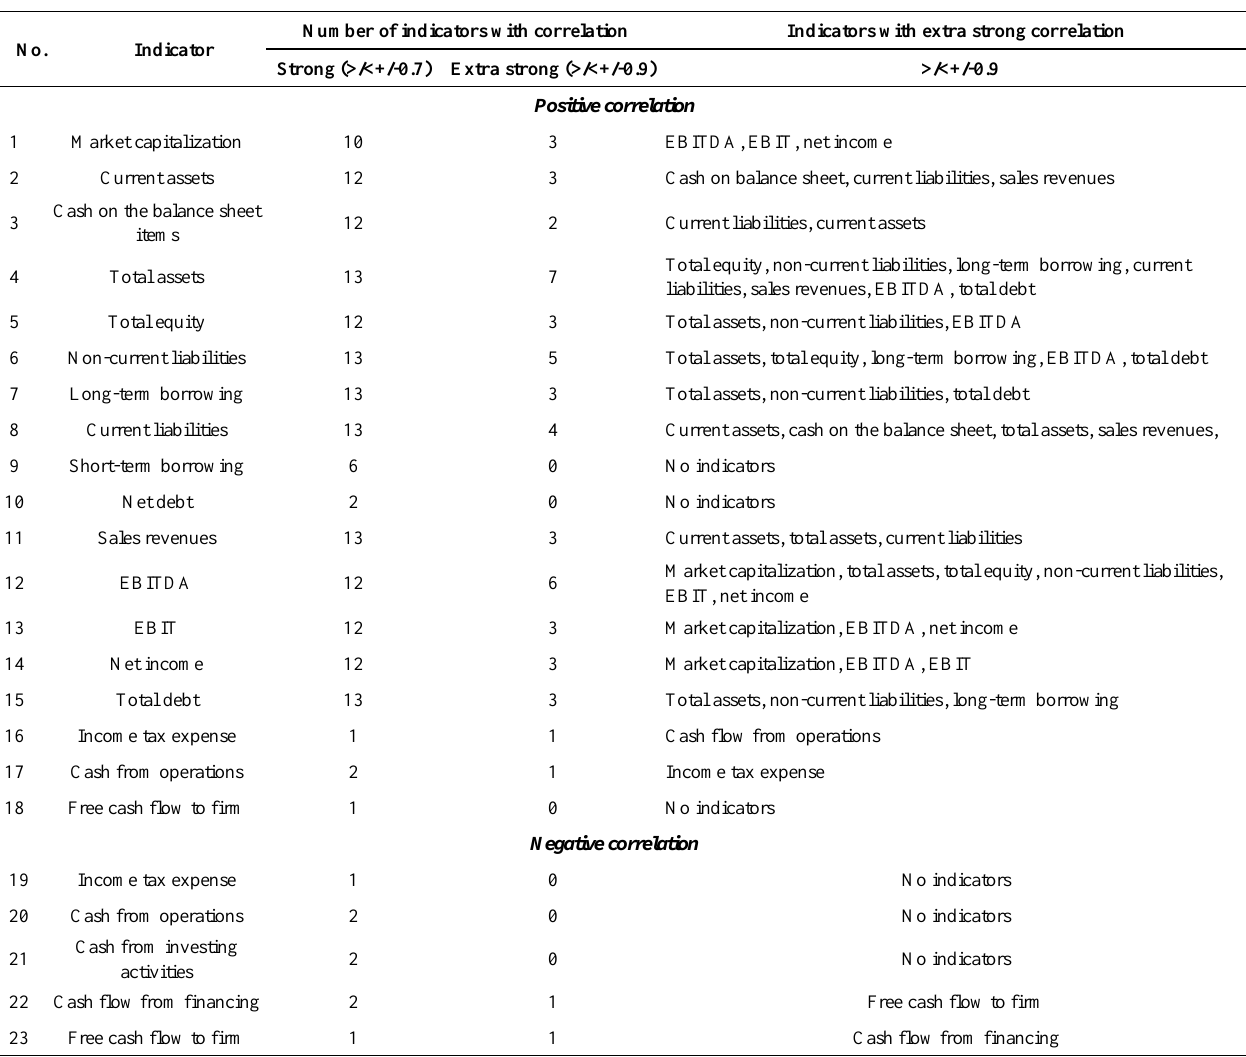
Table 2. Multi correlation matrix results summary of 510 Nordic countries stock market listed companies’ absolute value indicators in 2004-2018. Number of indicators with correlation Indicators with extra strong No. Indicator